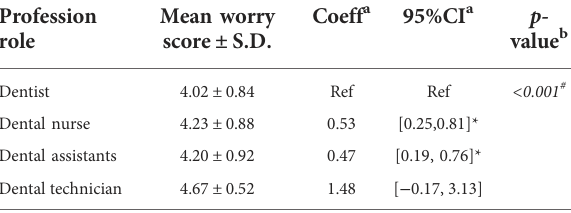
TABLE 1 Worry score and types of occupation roles ( N =1177).